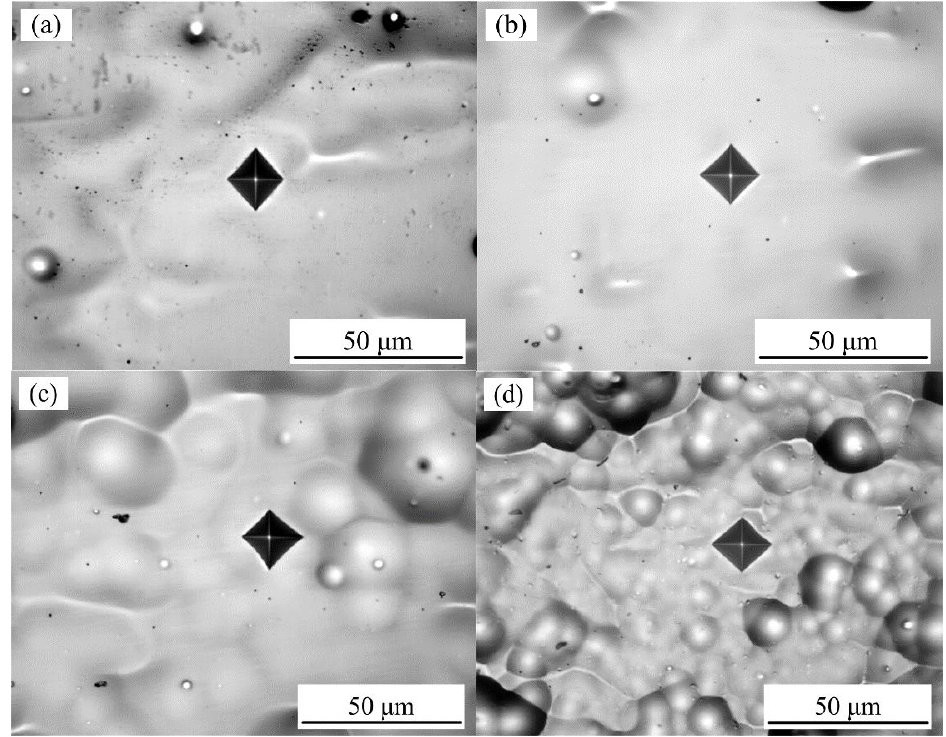
Figure 6. Microhardness of Ni–Co–P alloy coatings as a function of: ( a ) jet voltages; ( b ) the temperature of plating solution.